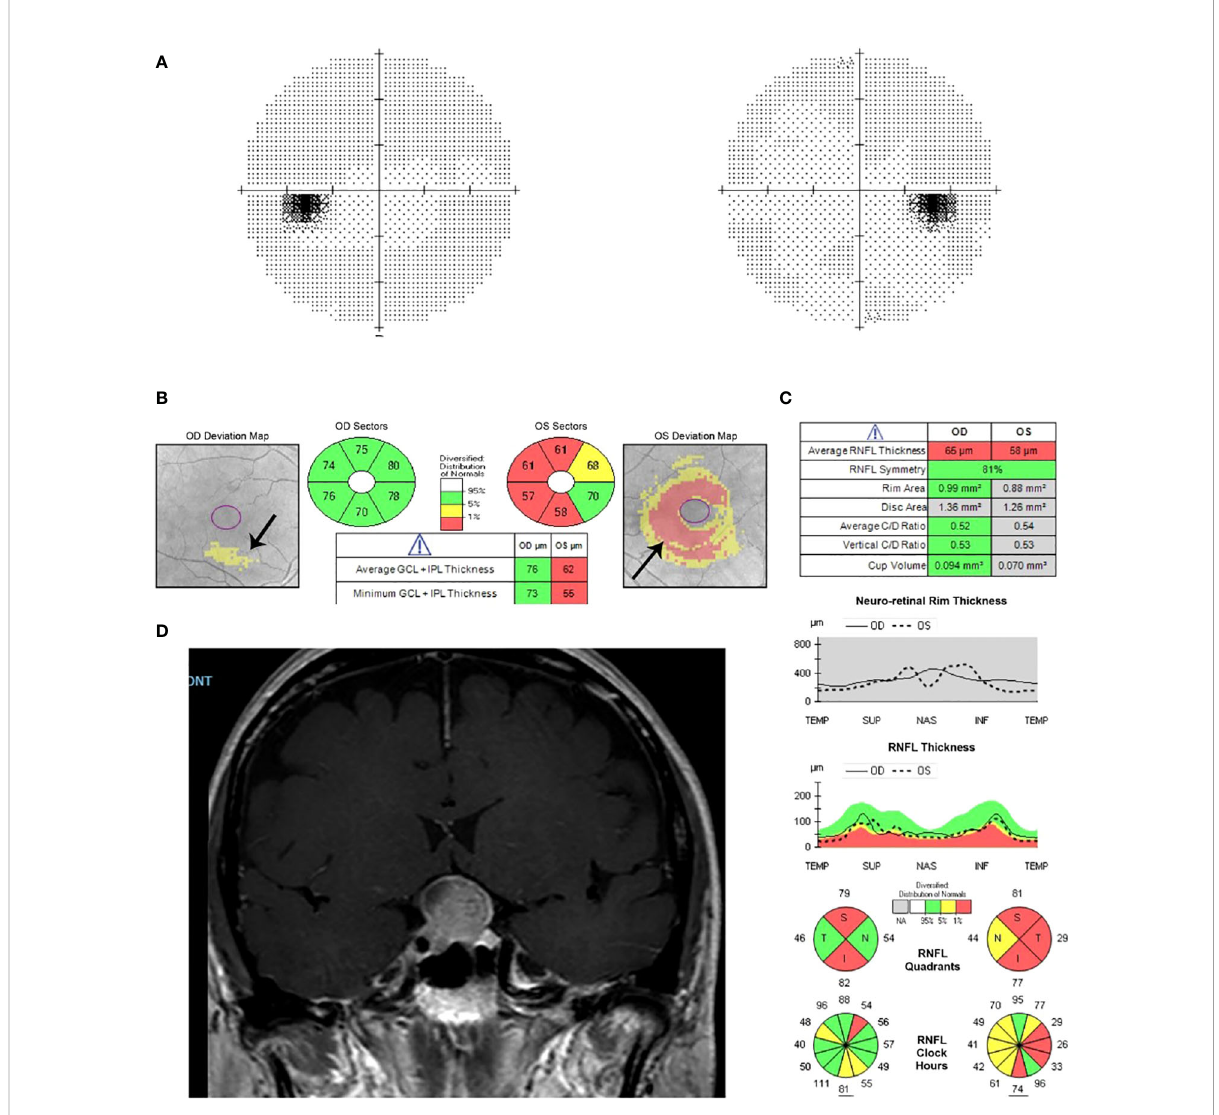
FIGURE 3 Humphrey visual fi eld 24-2 and OCT with ganglion cell analysis and retinal nerve fi ber layer thickness of a patient with sellar and suprasellar meningioma. (A) Normal visual fi eld test. (B) Evidence of ganglion cell layer loss in the left eye, especially nasally. (C) Thinning of the retinal nerve fi ber layer in both eyes. (D) MRI shows meningioma of the sellar and suprasellar region with homogenous enhancement on T1 with